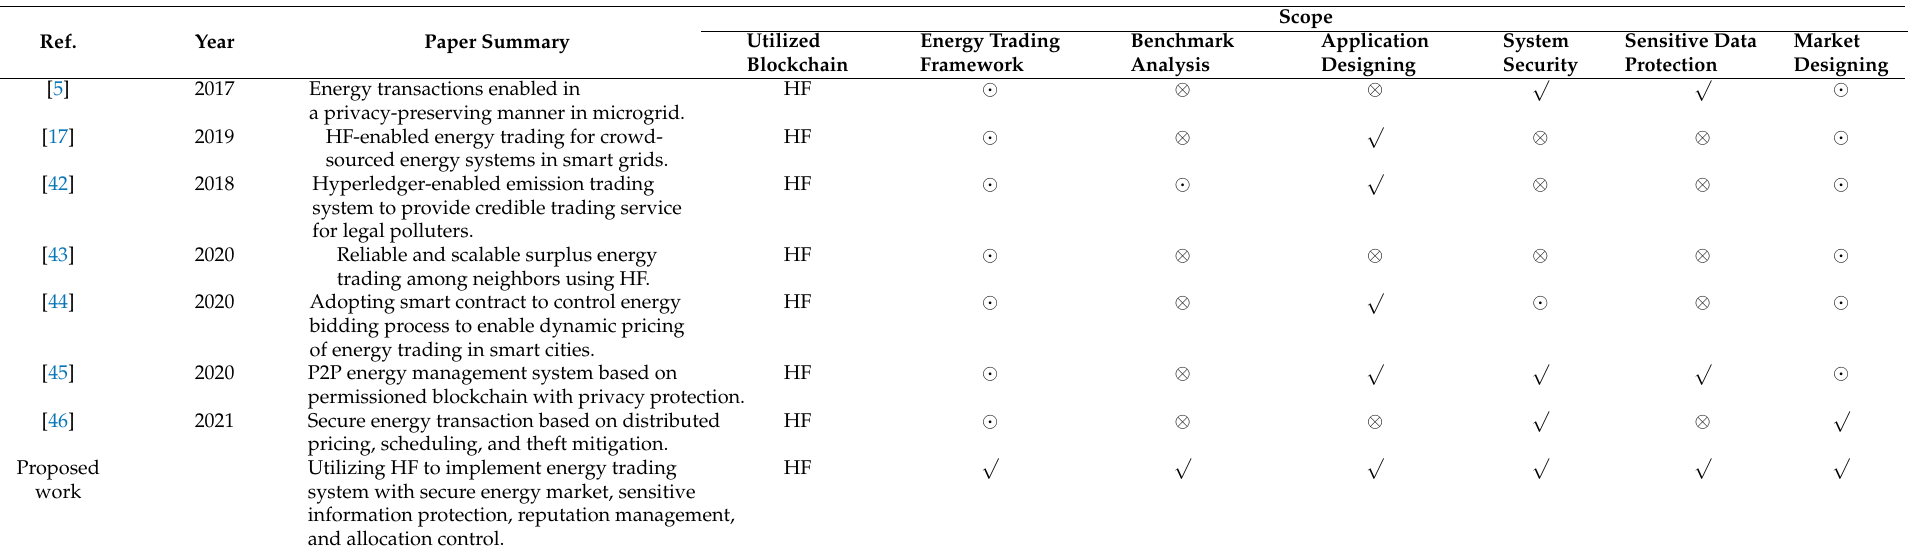
Table 3. Comparison between recent works in energy trading and our